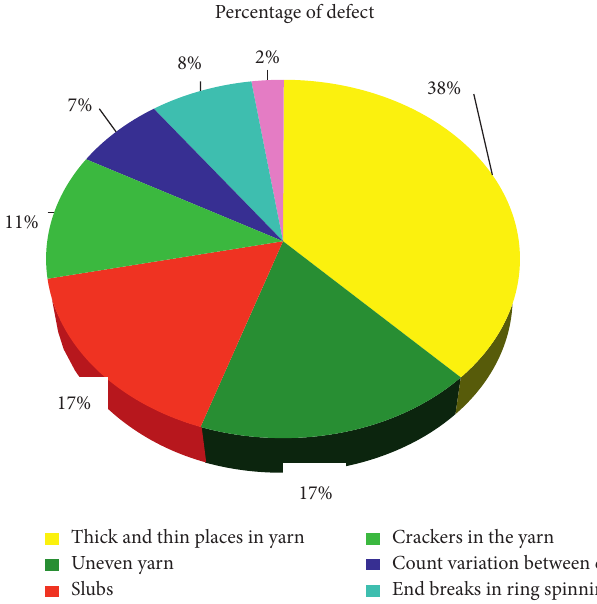
Figure 2: Defects frequently occurring in ring spinning